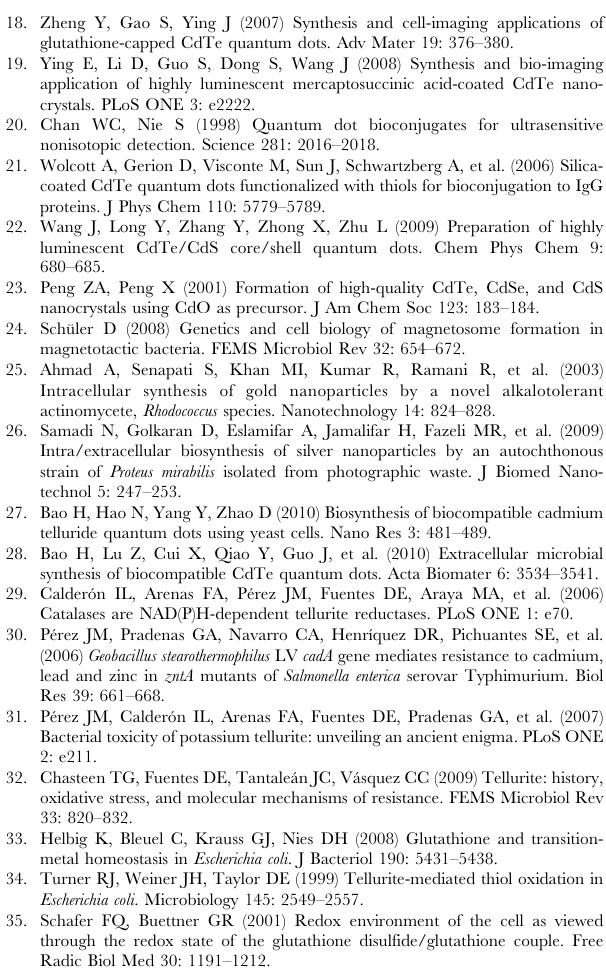
Figure S1 Raman vibrational spectra of GSH (a) and CdTe-GSH QDs (b). (TIF) Figure S2 Confocal fluorescence images of MKN45 cells incubated with 25 or 50 m g/ml CdTe-GSH quantum dots in the presence of lipofectamine (25 QD + L or 50 QD + L). QDs are shown in green and cell cytoplasm was stained by phalloidin (red). (TIF) Figure S3 Characterization of cell death in MKN45 cells incubated with QDs at the indicated concentrations (mg/ml), with or without lipofectamine. (TIF) Table S1 Cd and Te content in the as-prepared NPs as determined by